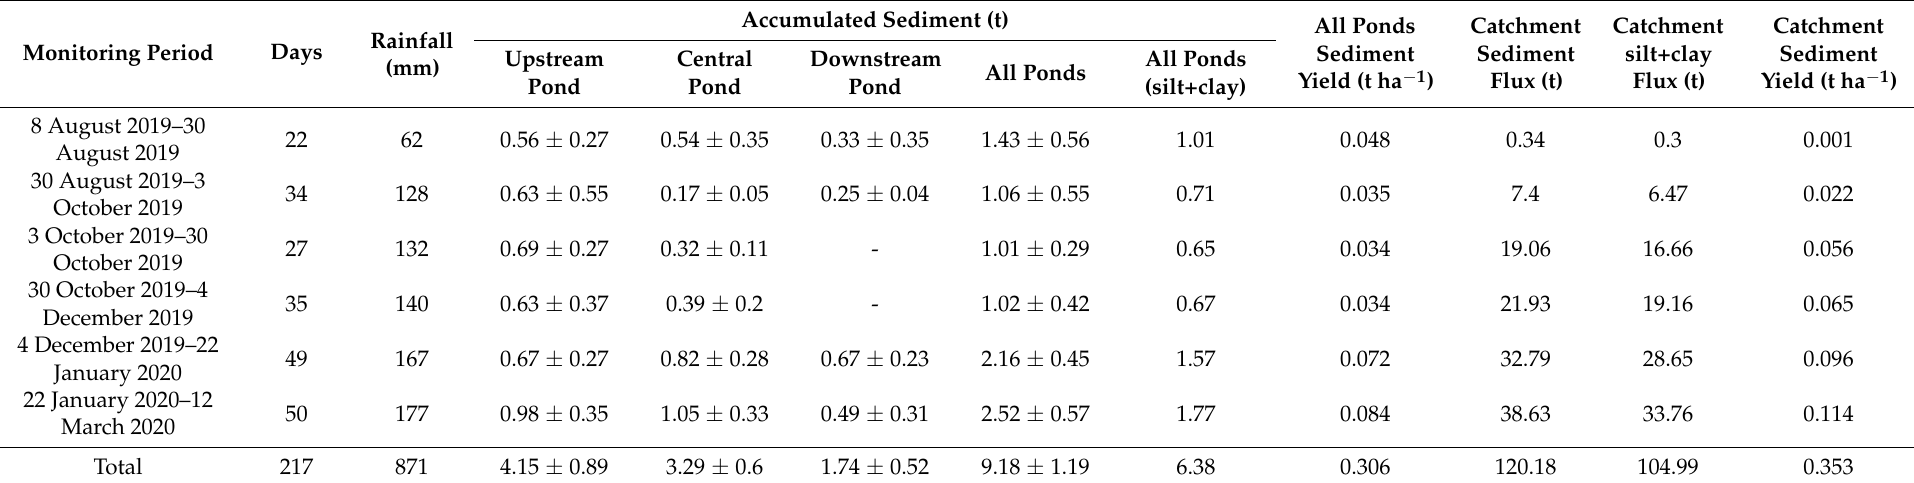
Table 4. Accumulated sediment ( ± SD) (t) in each pond, all three ponds, and only the silt + clay (<63 µ m) for sediment trap monitoring periods. Accumulated sediment yield (t ha − 1 ) for all ponds from the contributing area (30 ha), the flux of sediment and silt + clay (t) and the exported yield (t ha − 1 ) from the downstream catchment area (340 ha) are given for the same periods. Monitoring Period Days